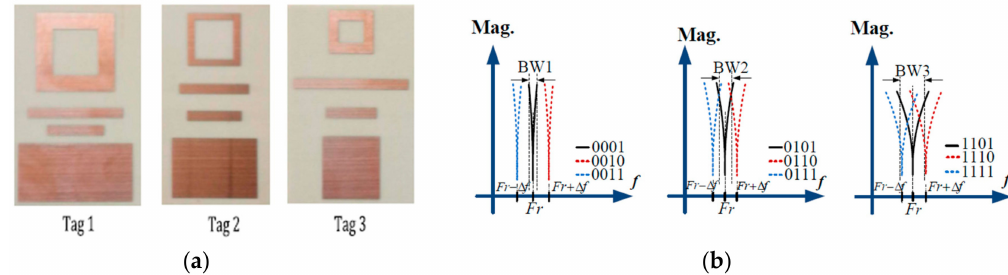
Figure 22. ( a ) Photograph of three chipless-RFID tags proposed by El-Awamry et al. and ( b ) the working principle of the proposed encoding. Figure extracted from